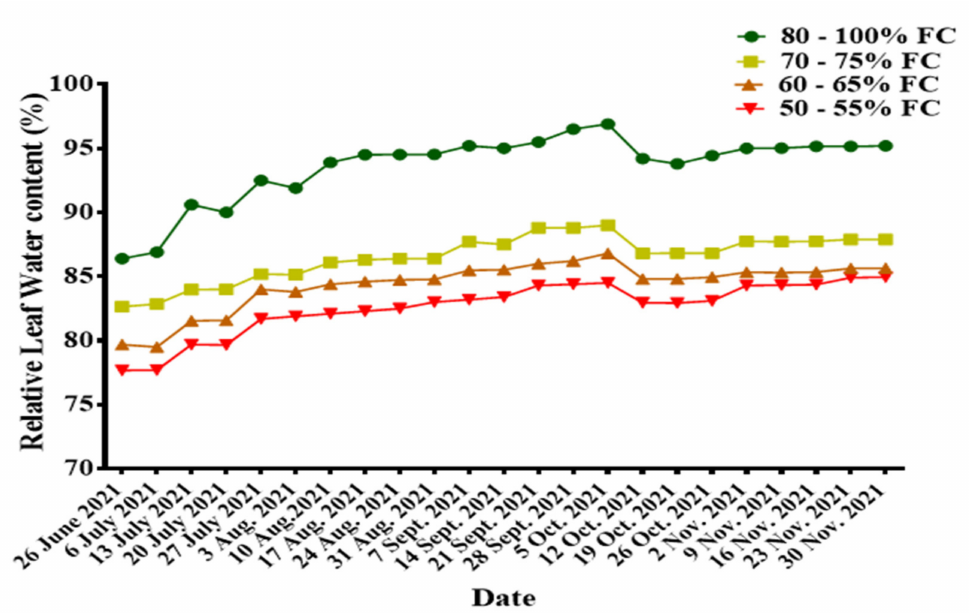
Figure 4. Seasonal variations in relative leaf water